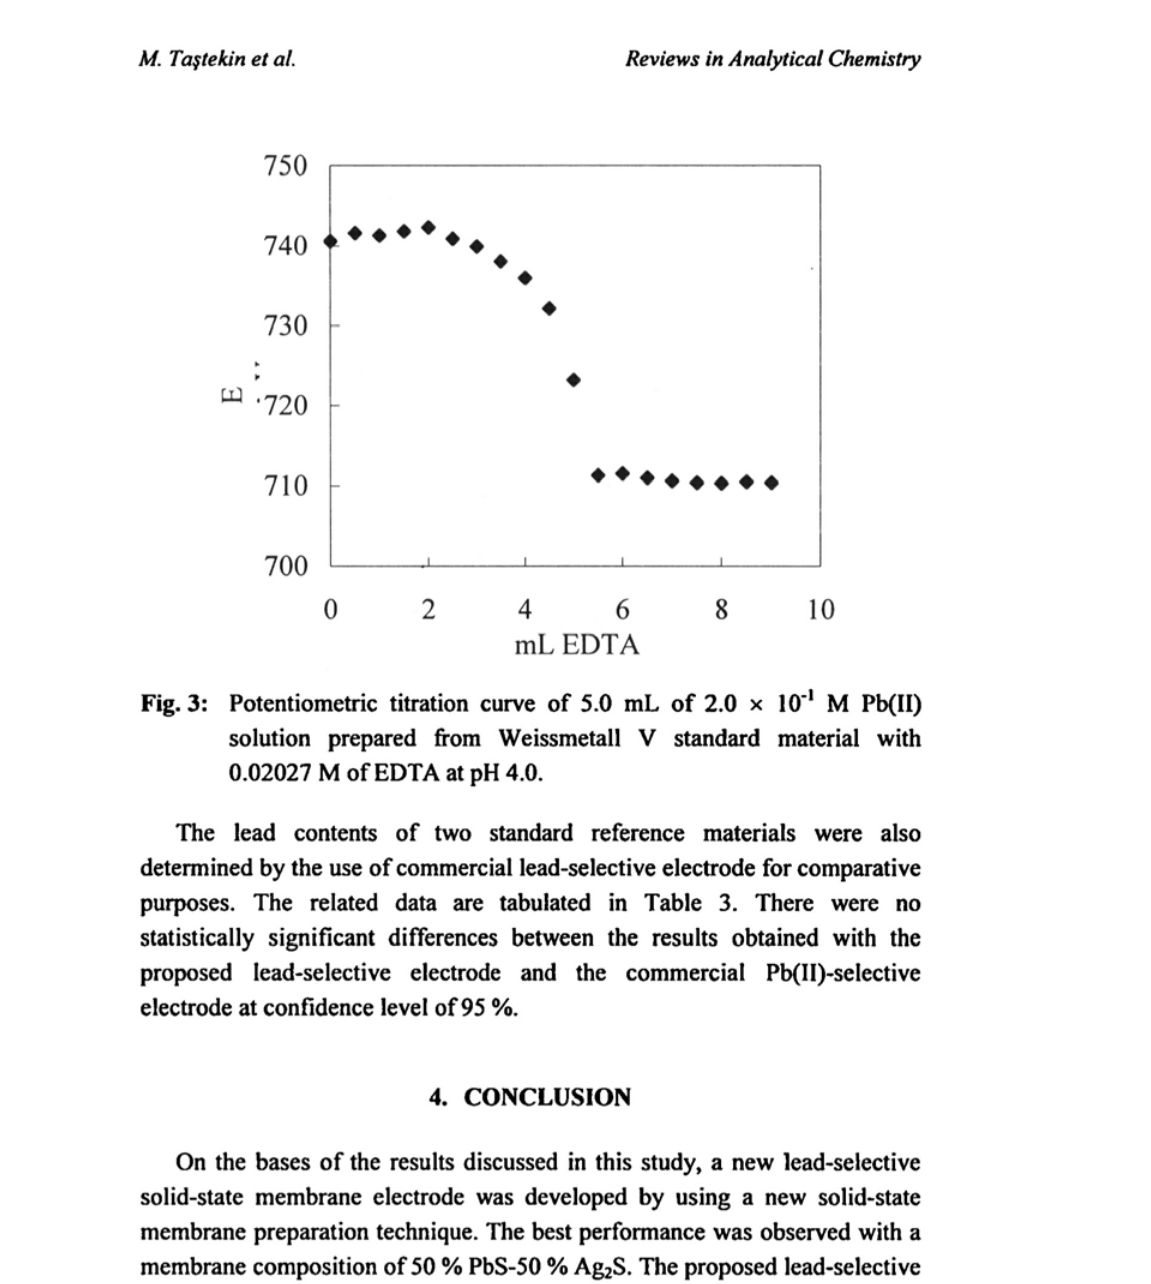
Fig. 3: Potentiometric titration curve of 5.0 mL of 2.0 χ 10"' M Pb(II) solution prepared from Weissmetall V standard material